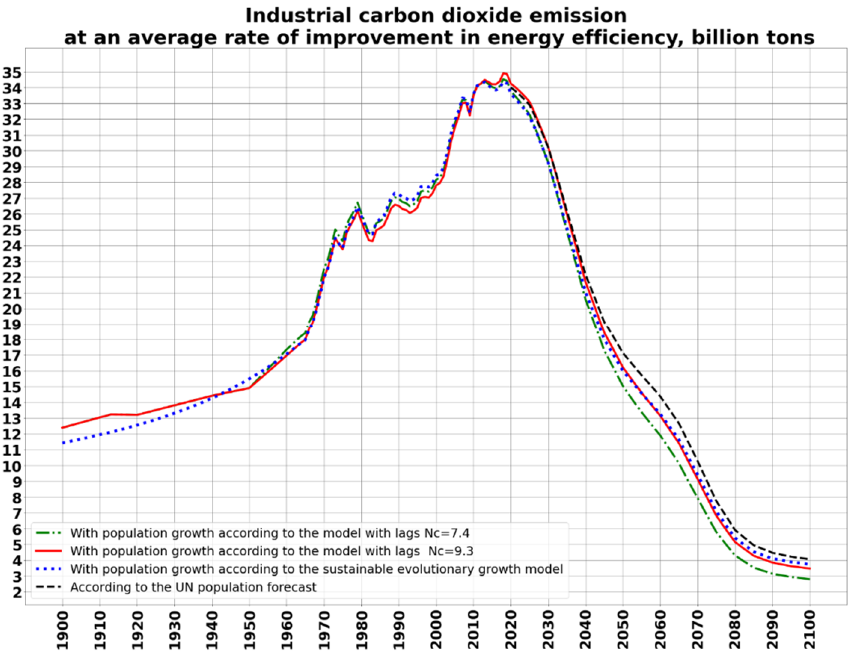
Figure 22. Dynamics of reduction of industrial CO 2 emissions into the atmosphere under the ambi- tious energy transition scenario using CCS technology.